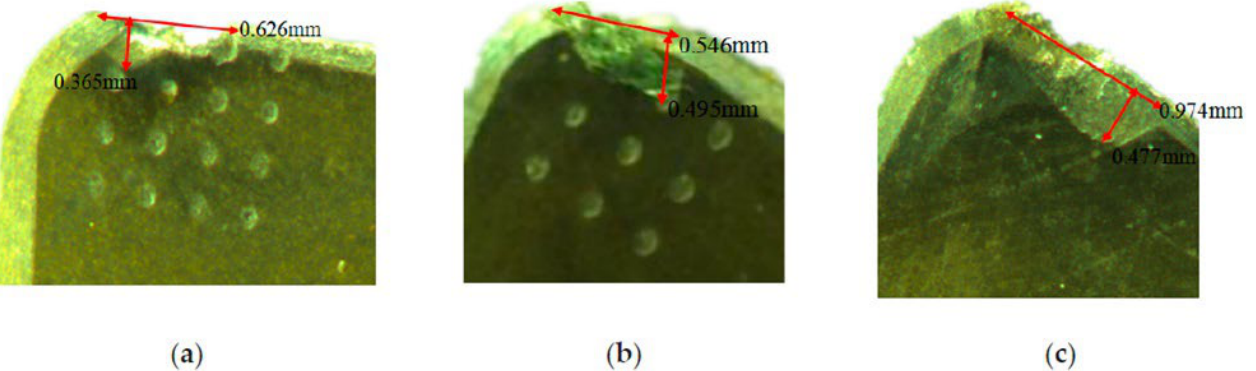
Figure 12. The micrograph of tool wear: ( a ) d = 80 µm micro-hole tool; ( b ) d = 120 µm micro-hole tool; ( c ) non-textured tool [78] .